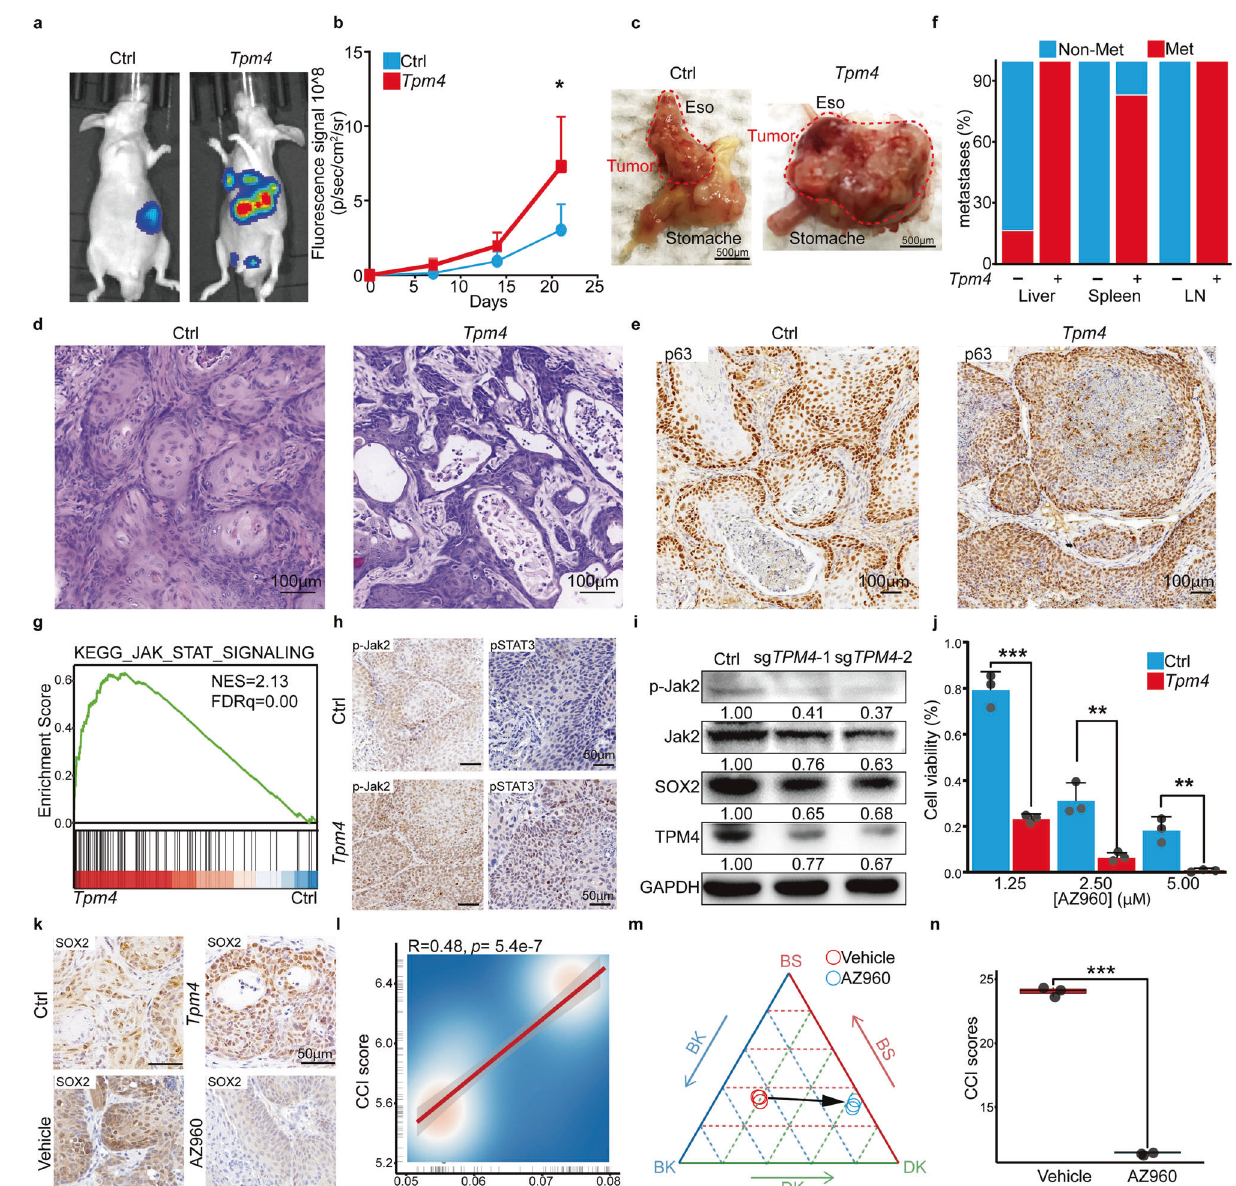
Fig. 4 TPM4 promotes CCI and ESCC aggressiveness through the Jak/STAT pathway. a Representative living images after orthotopic transplantation of control (left) and Tpm4 (right) overexpressed tumor organoids, each group consisting of six mice. b The luciferase fl uorescence signal intensity of the control and Tpm4 overexpressed mice after orthotopic transplantation. Data shows the means ± SEM. ( n = 6 independent biological replicates were performed for each group). p Values calculated by two-sided unpaired t -test. *, p < 0.05. c Representative bright- fi eld images of the orthotopic esophageal tumor tissue derived from the control (left) and Tpm4 overexpressed (right). Scale bar, 500 μ m. d Representative H&E staining images of primary orthotopic tumors derived from the control (left) and Tpm4 overexpressed (right). Scale bar, 100 μ m. e Representative immunohistochemistry images of p63 in orthotopic control and Tpm4 overexpressed tumors. Scale bar, 100 μ m. f The percentages of the control or Tpm4 overexpressed mice with indicated numbers of metastases in liver, spleen, and lymph nodes (LN) were summarized. (Each group consists of n = 6 mice). g The GSEA plot showed the Jak/STAT signaling pathways enriched in Tpm4 overexpressed samples. h Representative immunohistochemistry images of p-Jak2 and pSTAT3 in subcutaneous control and Tpm4 tumors. Scale bar, 50 μ m. i The representative western blotting pictures showed the p-Jak2, Jak2, SOX2, TPM4, and GAPDH levels in the control or TPM4 disrupted organoids. j The viability of control and Tpm4 overexpressed tumor organoids in different concentrations of AZ960. Data are shown as mean ± SD. ( n = 3 independent biological replicates were performed for each group). p Values calculated by two-sided unpaired t -test. ** p < 0.01; *** p < 0.001. k Representative immunohistochemistry images of SOX2 in subcutaneous control and Tpm4 overexpressed tumors (top) and in subcutaneous Tpm4 overexpressed tumors treated with vehicle and AZ960 (bottom). Scale bar, 50 μ m. l The scatter plot showed the correlation between the expression levels of Jak/STAT and CCI scores in scRNA. m The ternary diagram showed the similarity/variation in RNA- seq data of Tpm4 overexpressed organoids treated with vehicle and AZ960, with BS, BK, and DK cells. Three independent biological replicates were performed for each group. n The boxplot showed the CCI scores in Tpm4 overexpressed organoids treated with vehicle and AZ960 ( n = 3 organoids, Vehicle; n = 3 organoids, AZ960). Three independent biological replicates were performed for each group. p Values calculated by two-sided unpaired t -test. *** p < 0.001